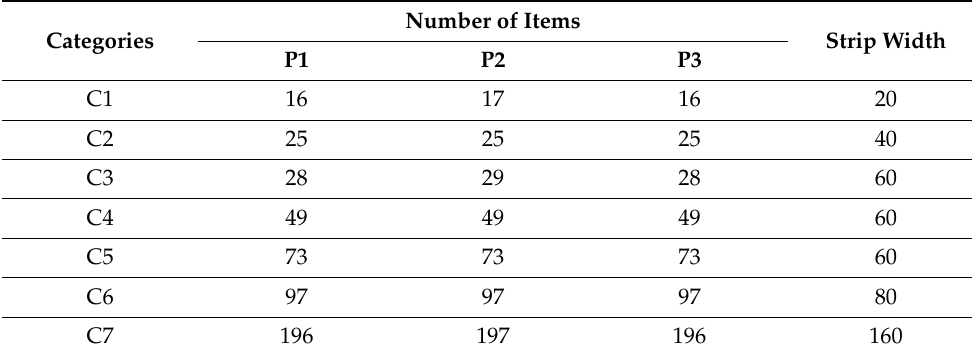
Table 3. Data parameters of Set